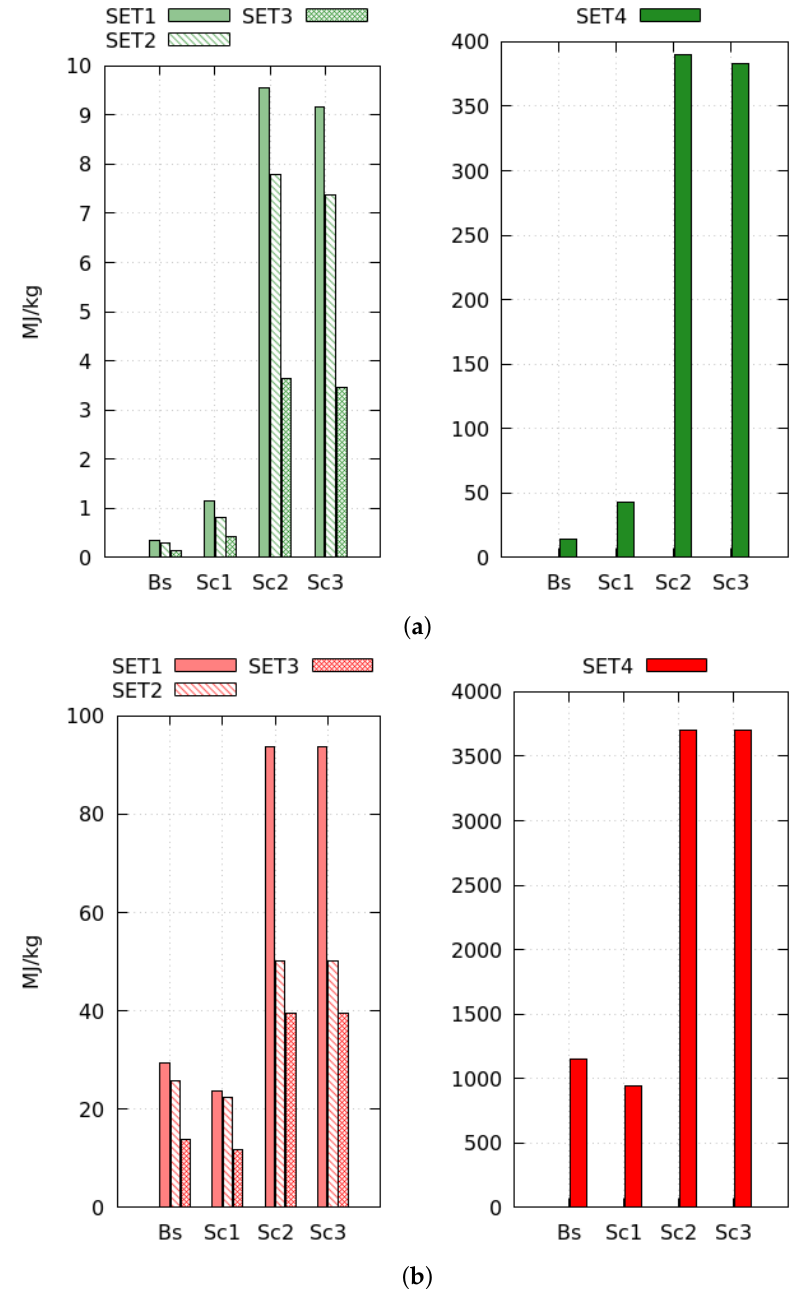
Figure 16. Specific electric energy consumption (SEEC) ( a ) and the specific thermal energy consump- tion (STEC) ( b ) collected by operative